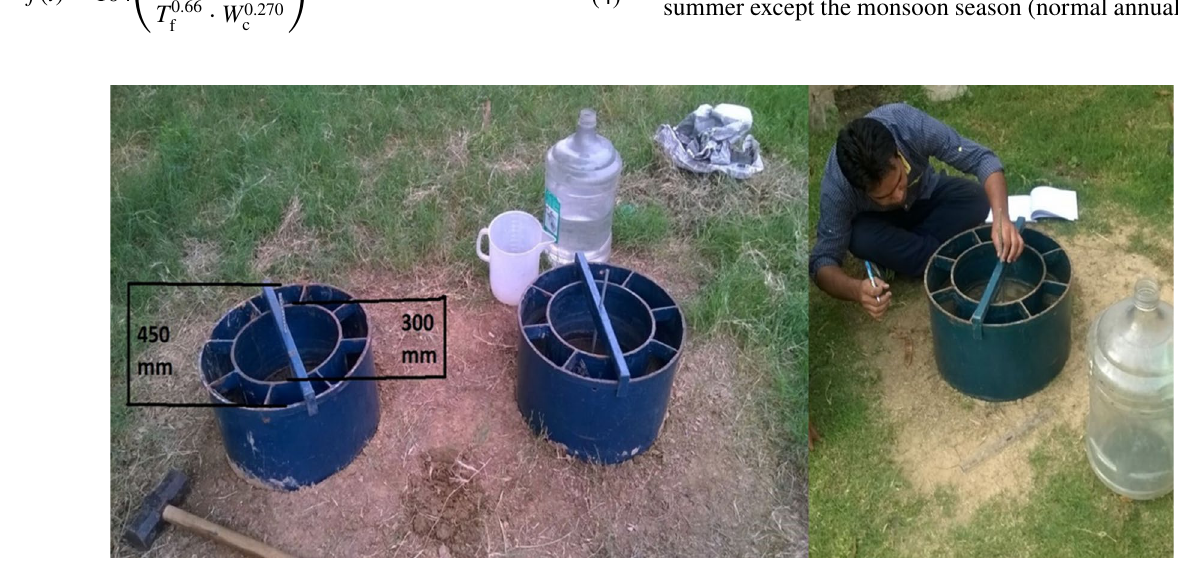
Fig. 1 Double-ring